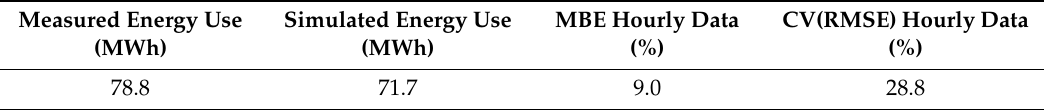
Table 8. Di ff erences between simulated and measured energy to the hydronic radiators. Hourly values for three-month occupied time period, January to April 2015.